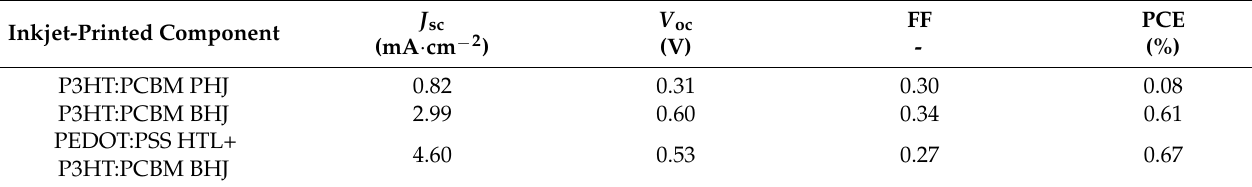
Table 1. Summary of OSC performances (short-circuit current, J sc ; open-circuit voltage, V oc ; fill factor, FF; power conversion efficiency, PCE) for solar cells having PET/ITO/PEDOT:PSS/P3HT:PCBM (PHJ or BHJ)/Al structure and differing from each other in the number and type of components deposited by IJP. In particular, the investigated printed components are the P3HT:PCBM PHJ, the P3HT:PCBM BHJ, and the HTL+BHJ in which both the PEDOT:PSS HTL and the P3HT:PCBM BHJ are realized by